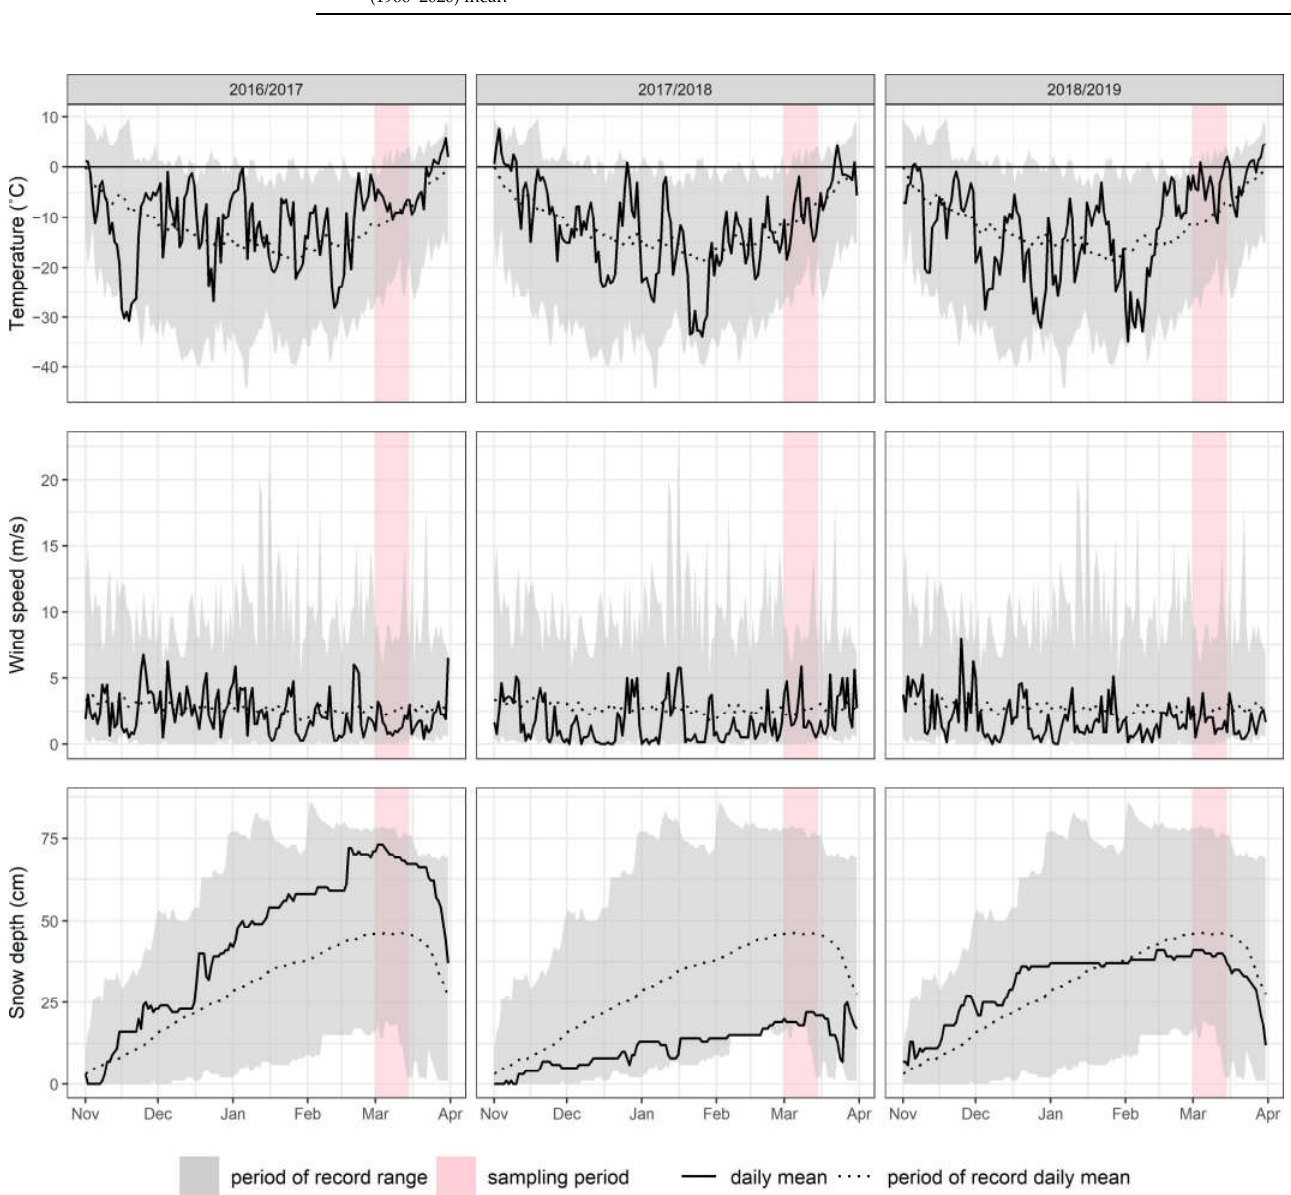
Figure 2. Barnaul weather station air temperature, wind speed, snow depth for the studied winter seasons as well as the station period of record (1966–2020). The strongest differences were observed in snow cover dynamics. The maximum snow depth values were above average in 2016/2017 (73 cm) and extremely below